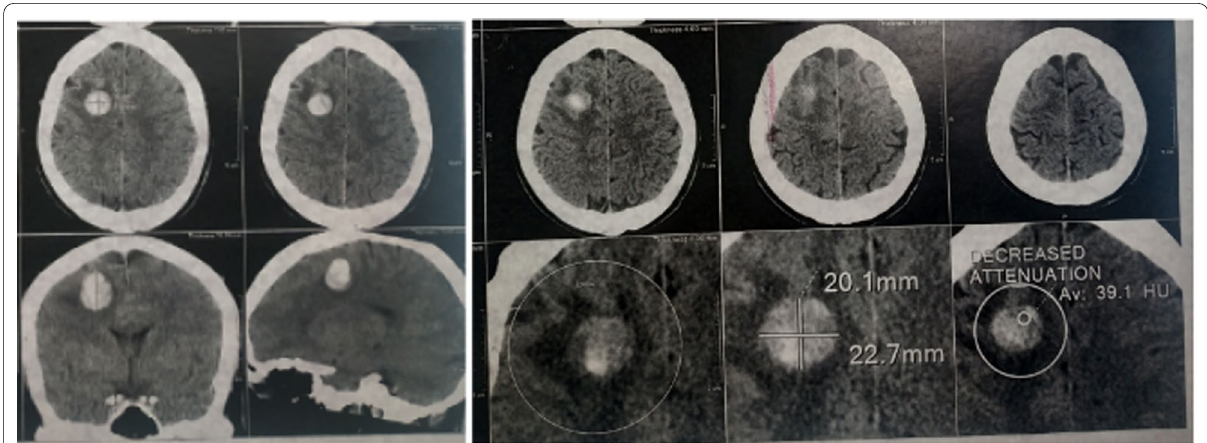
Fig. 10 CT pre‑op of cavernoma case. Right frontal well defined hyperdense lesion measuring 20.1